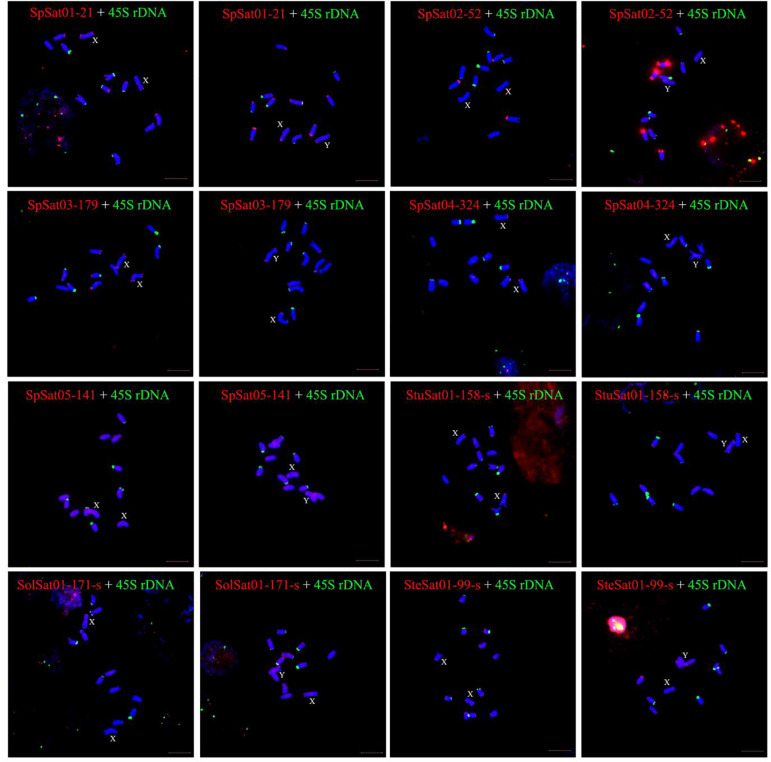
Localization of eight satellites on metaphase chromosomes of spinach using fluorescence in situ hybridization. The name of satellites and sex of individual are indicated inside each figure. Blue are DAPI stained chromosomes, the satellite DNAs were labeled with Texas red (red signal), and green signals show chromosomal localization of satellites. Bar indicates 10 μm.